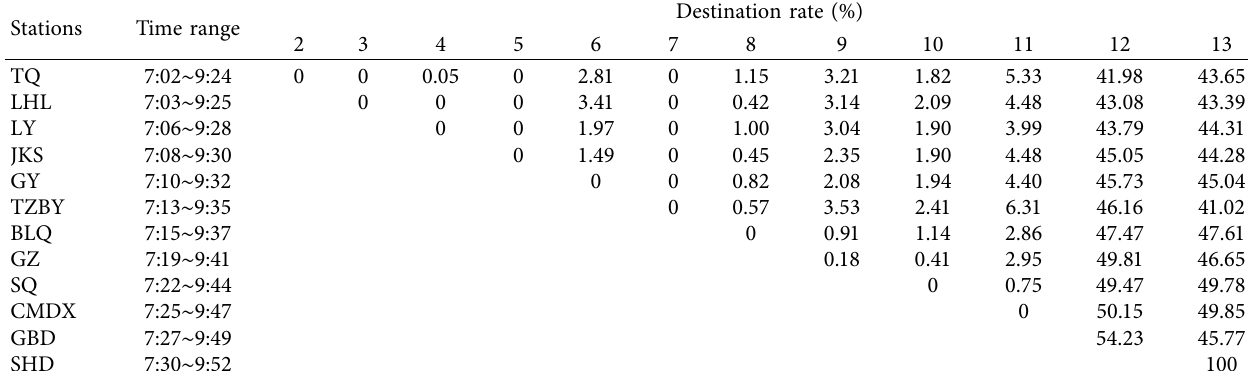
Table 6: Time range and destination rate for arrival passengers at each station.